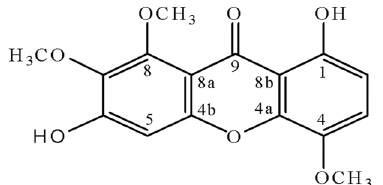
Figure 1. Structure of compound 1